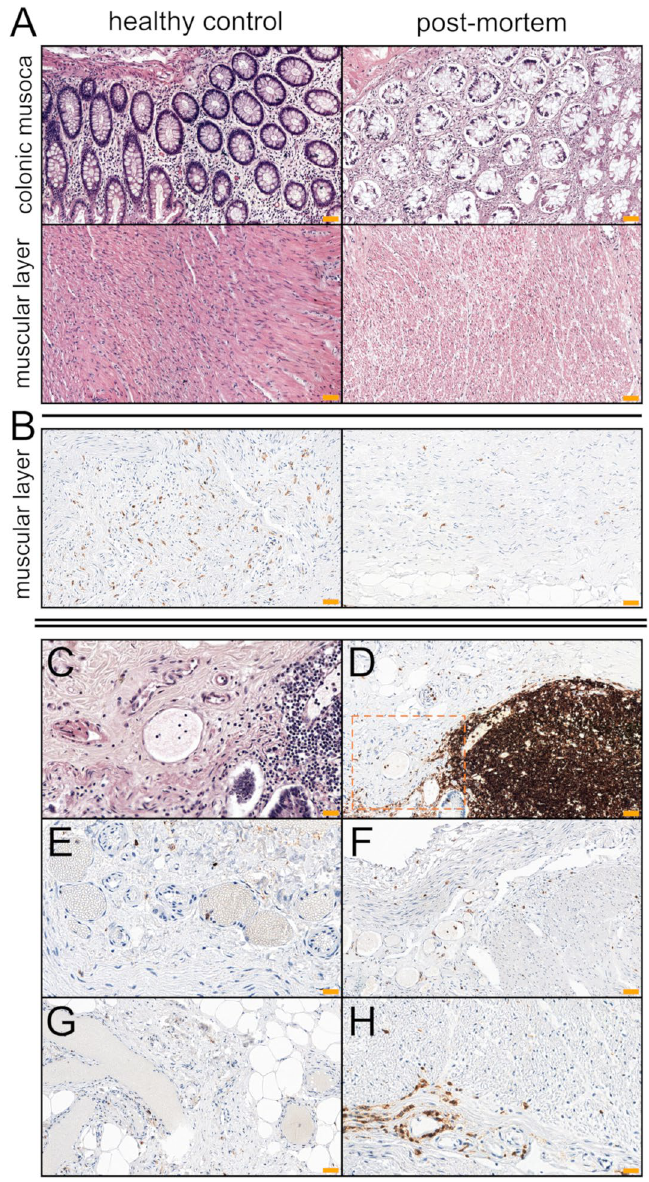
Figure 1. ( A ) Comparison of colonic glands and muscular layer between normal colonic mucosa (HC) and post-mortem samples (PM); H & E staining. As opposed to the normal colonic mucosa, the post-mortem samples showed discernible features of tissue autolysis, particularly pronounced within the colonic crypt. The features of early decomposition as well as slight fibrosis in the submucosal area and muscular layer were also observed. The PM cases also showed a thinner mucosa and muscularis mucosa thickness. ( B ) Mild inflammatory infiltrates (CD45 + cells) of the muscular layers were observed mostly in post-mortem samples. for which the starting points were most likely lymphoid clusters ( D ). The distribution of CD45 + cells in the post-mortem tissue was also higher in the vascular beds ( C , D , F , H ). In normal intestinal walls, the endovascular presence of immune cells was rarely present ( E , G ). The inflammatory nature of cells with vascular localization ( C ; H & E staining) was confirmed by immunohistochemical reactions against the CD45 antigen ( D ). Scale bars = 50